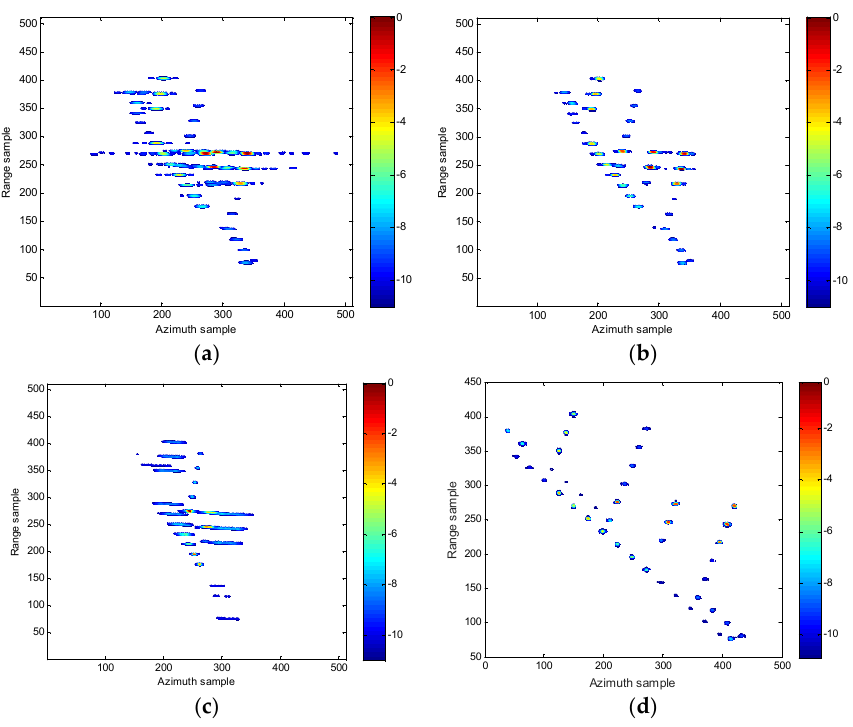
Figure 12. ISAR images of the simulated data under SNR = 5 dB in the case of uneven strengths of scatterers. ( a ) WVD algorithm in [12]. ( b ) SPWVD method in [13]. ( c ) RCD method in [15]. ( d ) Our proposed method.